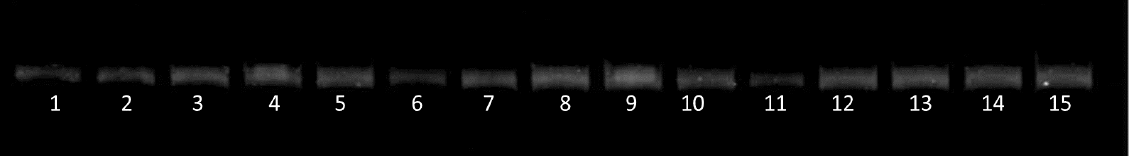
Figure 1. The effect of tested compounds on S. aureus topoisomerase IV activity. Decreasing amounts of 1 , 2 , or 3 were incubated with 200 ng kinetoplast DNA and run-on agarose gel. Lane: 1–5: compound 3 at concentrations 64, 32, 8, 2, 0.5 µ g/mL, respectively. Lane: 6–10: compound 2 at concentrations 64, 32, 8, 2, 0.5 µ g/mL, respectively. Lane: 11–15: compound 1 at concentrations 64, 32, 8, 2, 0.5 µ g/mL, respectively.